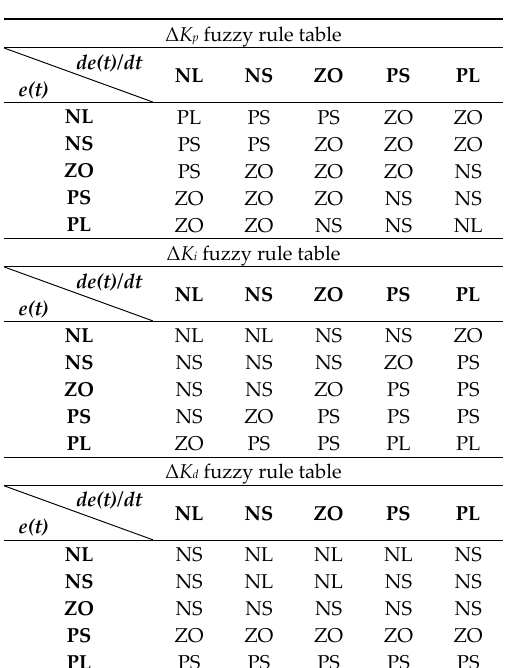
Table 4. Fuzzy rule table of three parameters . Δ K p fuzzy rule table.